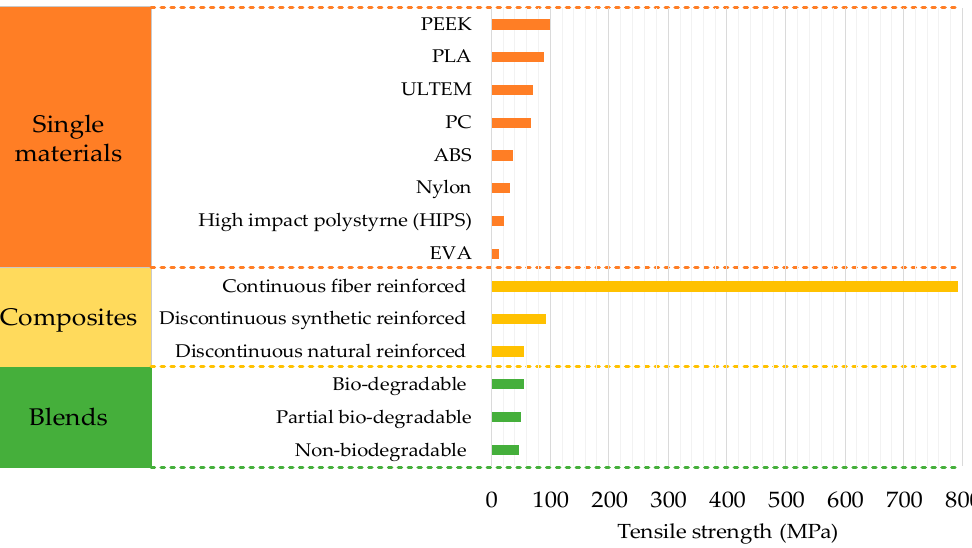
Figure 19. Strength range for different FFF materials.